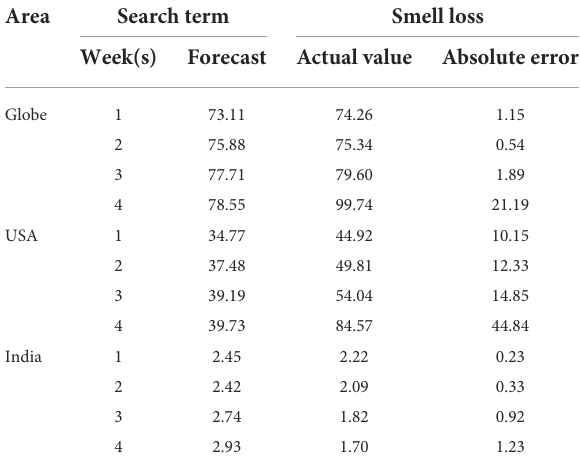
TABLE 9 Prediction results and absolute errors when the search term changed to “smell loss.”